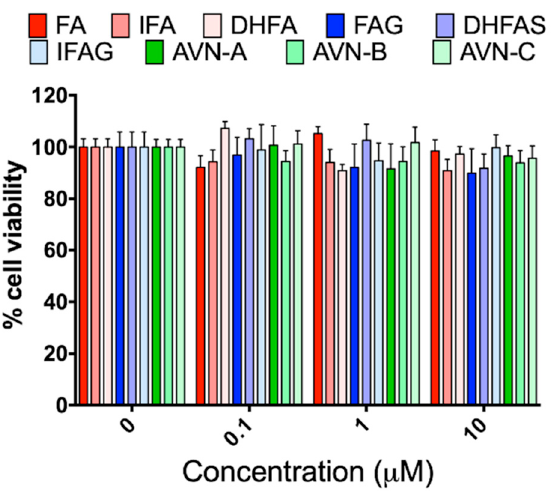
Figure 1. HUVEC cell viability, measured with the MTT assay, after pre-treatment with the oat phenolics and metabolites (0.1, 1 and 10 µ M) ferulic acid (FA) isoferulic acid (IFA), dihydroferulic acid (DHFA), FA glucuronide (FAG), DHFA glucuronide (DHFAG), IFA sulfate (IFAS), avenanthramide A (AVN-A) avenanthramide B (AVN-B) avenanthramide C (AVN-C) for 24 h. Data are expressed as percentage of control values (100%) and reported as average ± SEM of 4 independent experiments performed in triplicate. p > 0.05 vs. control ( n = 12).